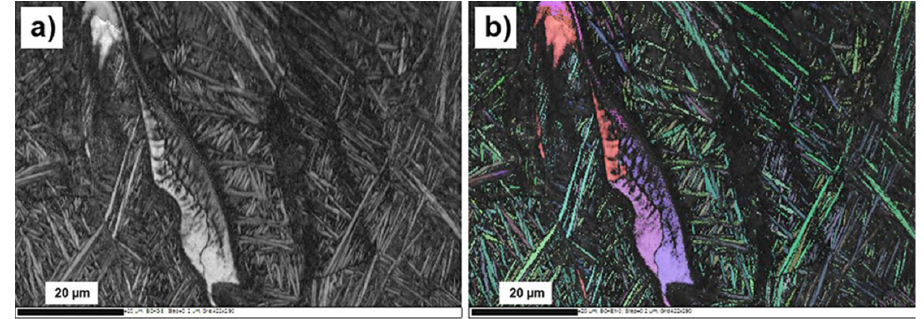
Figure 5. EBSD image of LPBF Ti6Al4V (ELI) ‐ 1 at % Cu, droplet ‐ shaped area with high concentration of Cu: ( a ) channeling contrast image; ( b ) EBSD map, shades of green color correspond to areas with hexagonal crystal lattice, areas of red ‐ purple color have cubic crystal lattice.